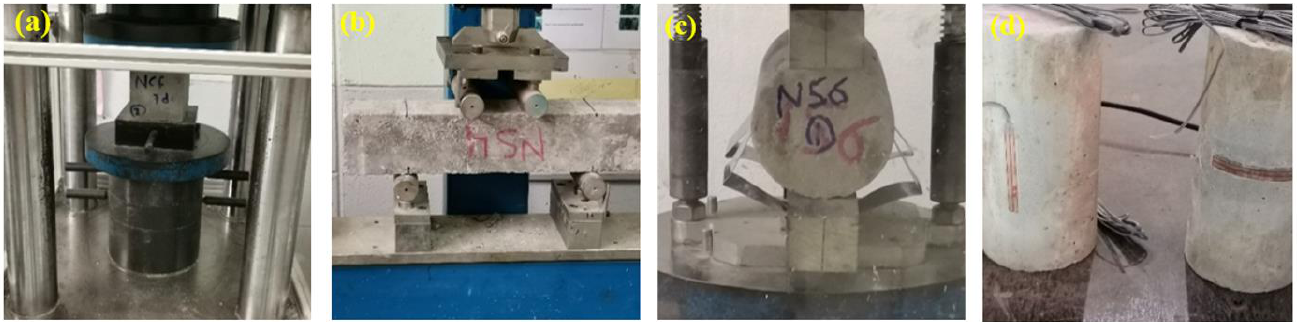
Figure 5. Mechanical tests of specimens ’ ( a ) compressive strength, ( b ) flexural strength, ( c ) splitting tensile, and ( d ) modulus of elasticity.